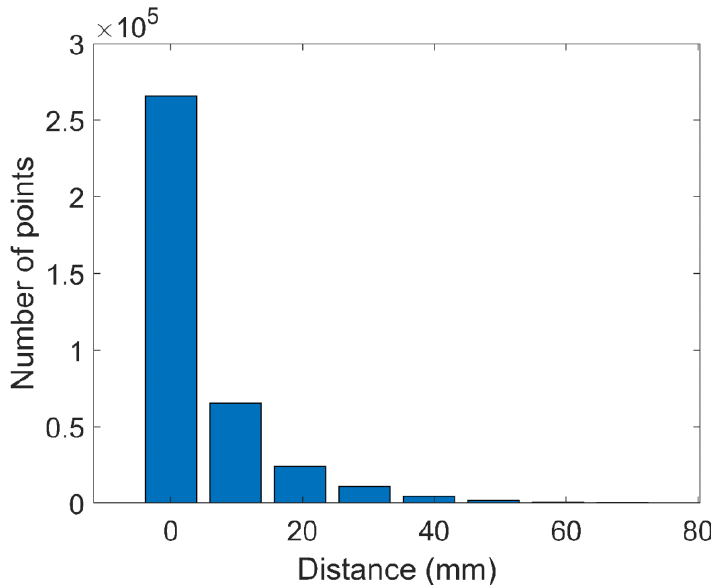
Figure 6. Cloud-to-cloud distance between the Faro Focus 3D and the LiVOX Avia.